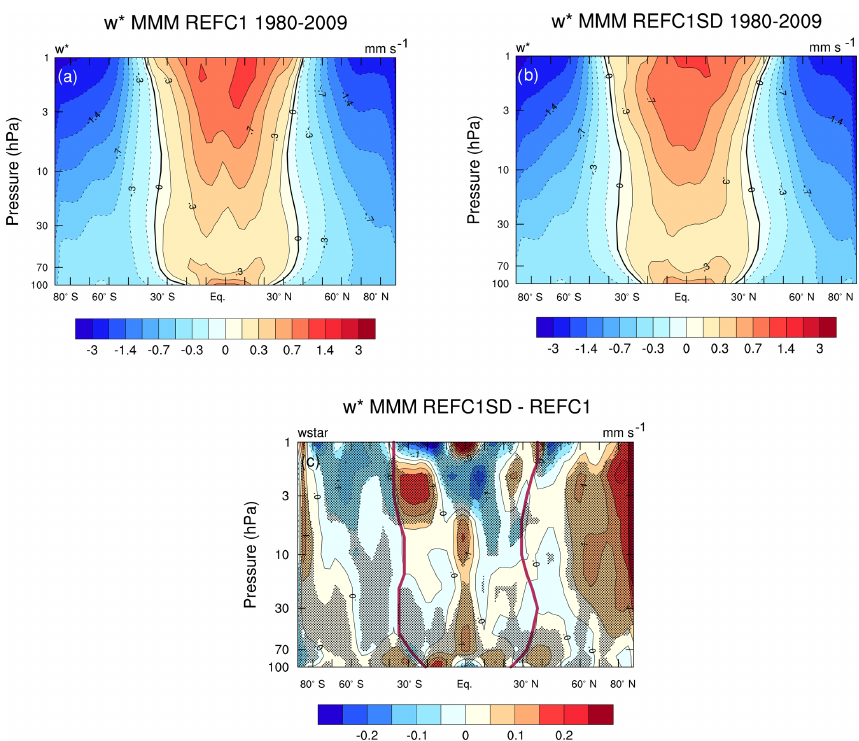
Figure 1. Latitude vs. pressure climatology (1980–2009) of MMM annual mean w ∗ for (a) REF-C1 simulations, (b) REF-C1SD simulations, and (c) the REF-C1SD–REF-C1 absolute differences. Shading denotes statistical significance at the 95% confidence level, and the red lines in (c) denote the climatological turnaround latitudes in REF-C1SD.